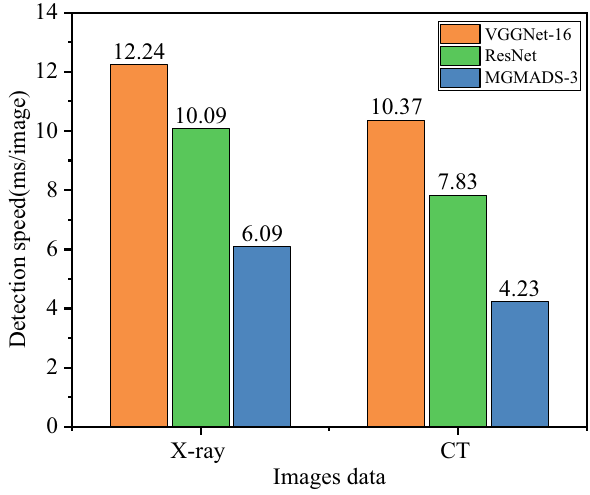
Figure 10. The detection speed comparisons of the three models.